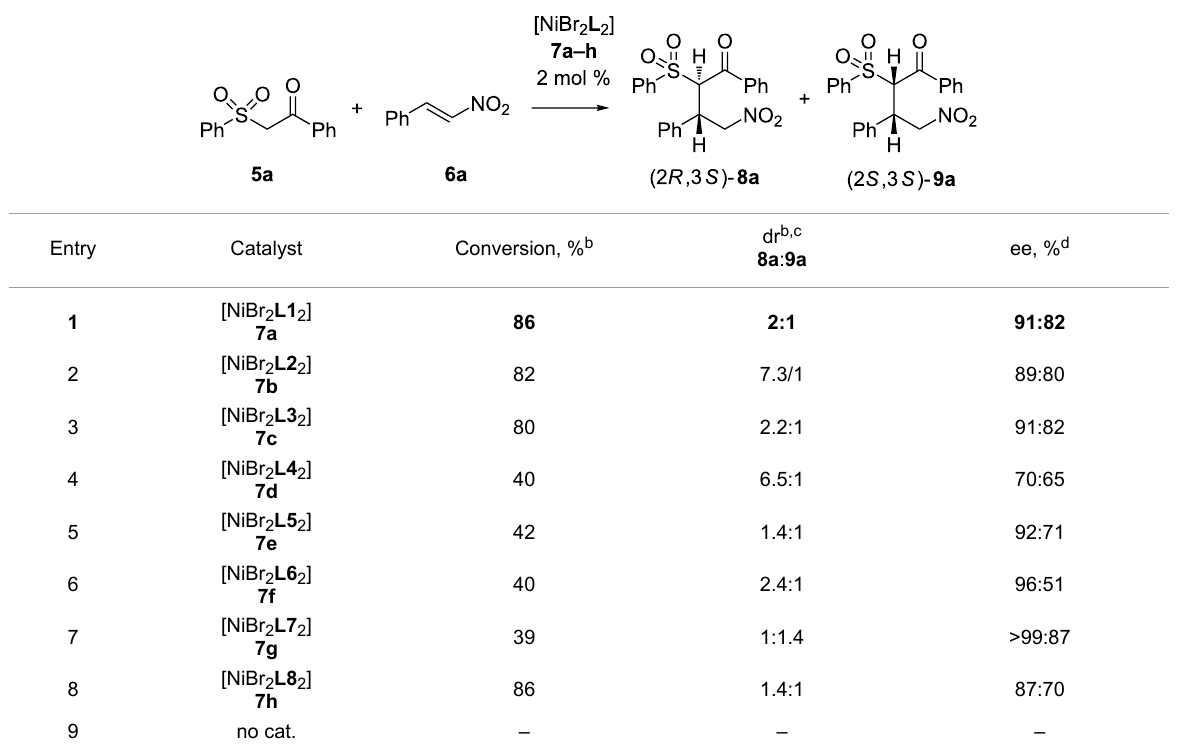
Table 1: Screening of Ni(II) complexes with chiral diamines in the asymmetric addition of 1-phenyl-2-(phenylsulfonyl)ethan-1-one ( 5 ) to ω -nitro- styrene ( 6a ) a